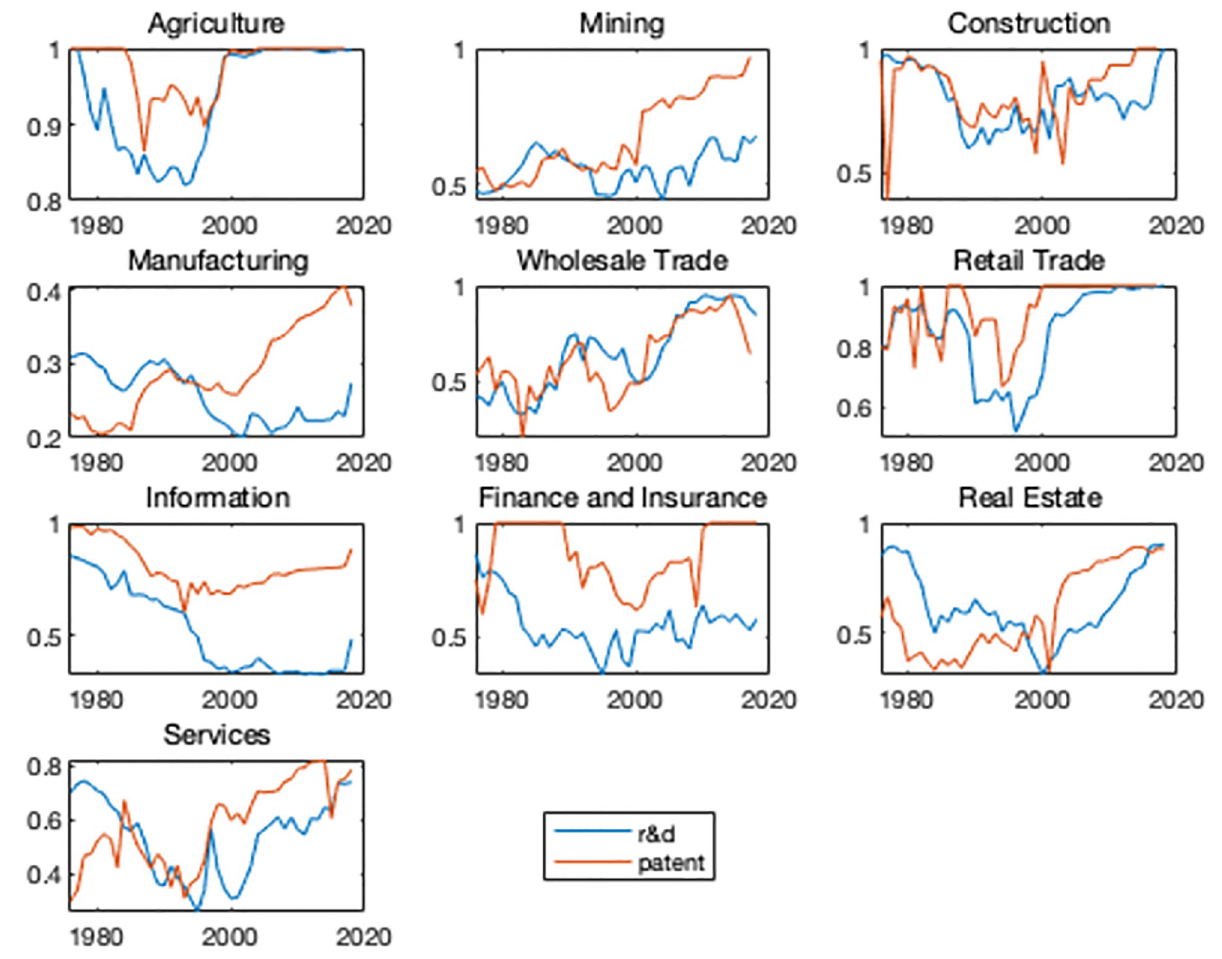
Fig 4. Share of the top 3